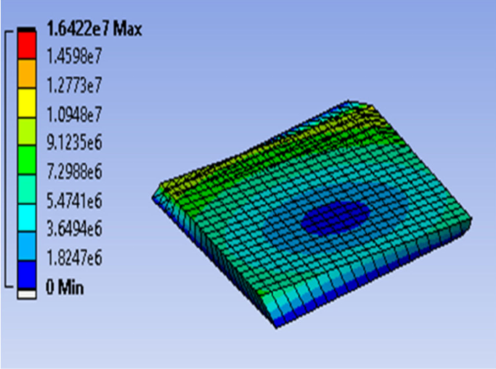
Figure 14. Total deformation in an uncontrolled environment